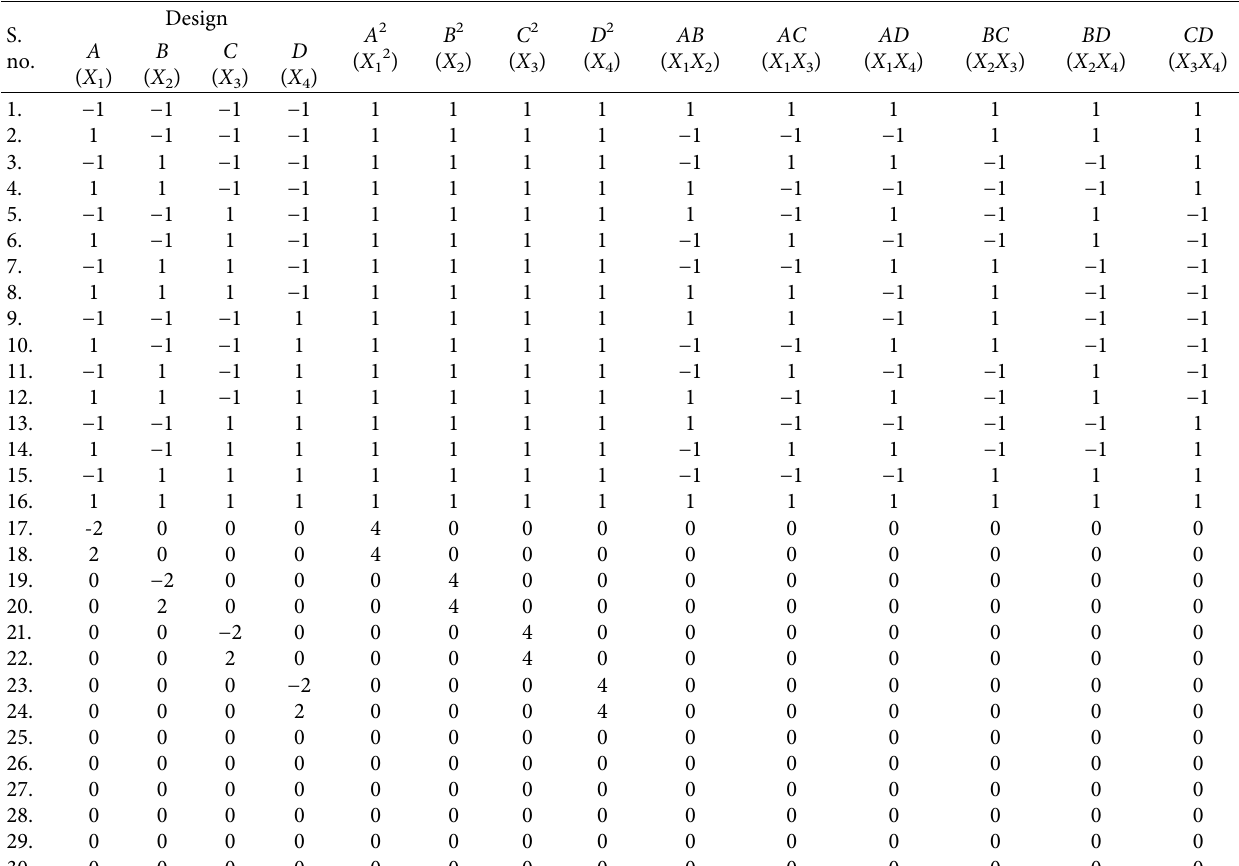
Table 3: Central composite rotatable